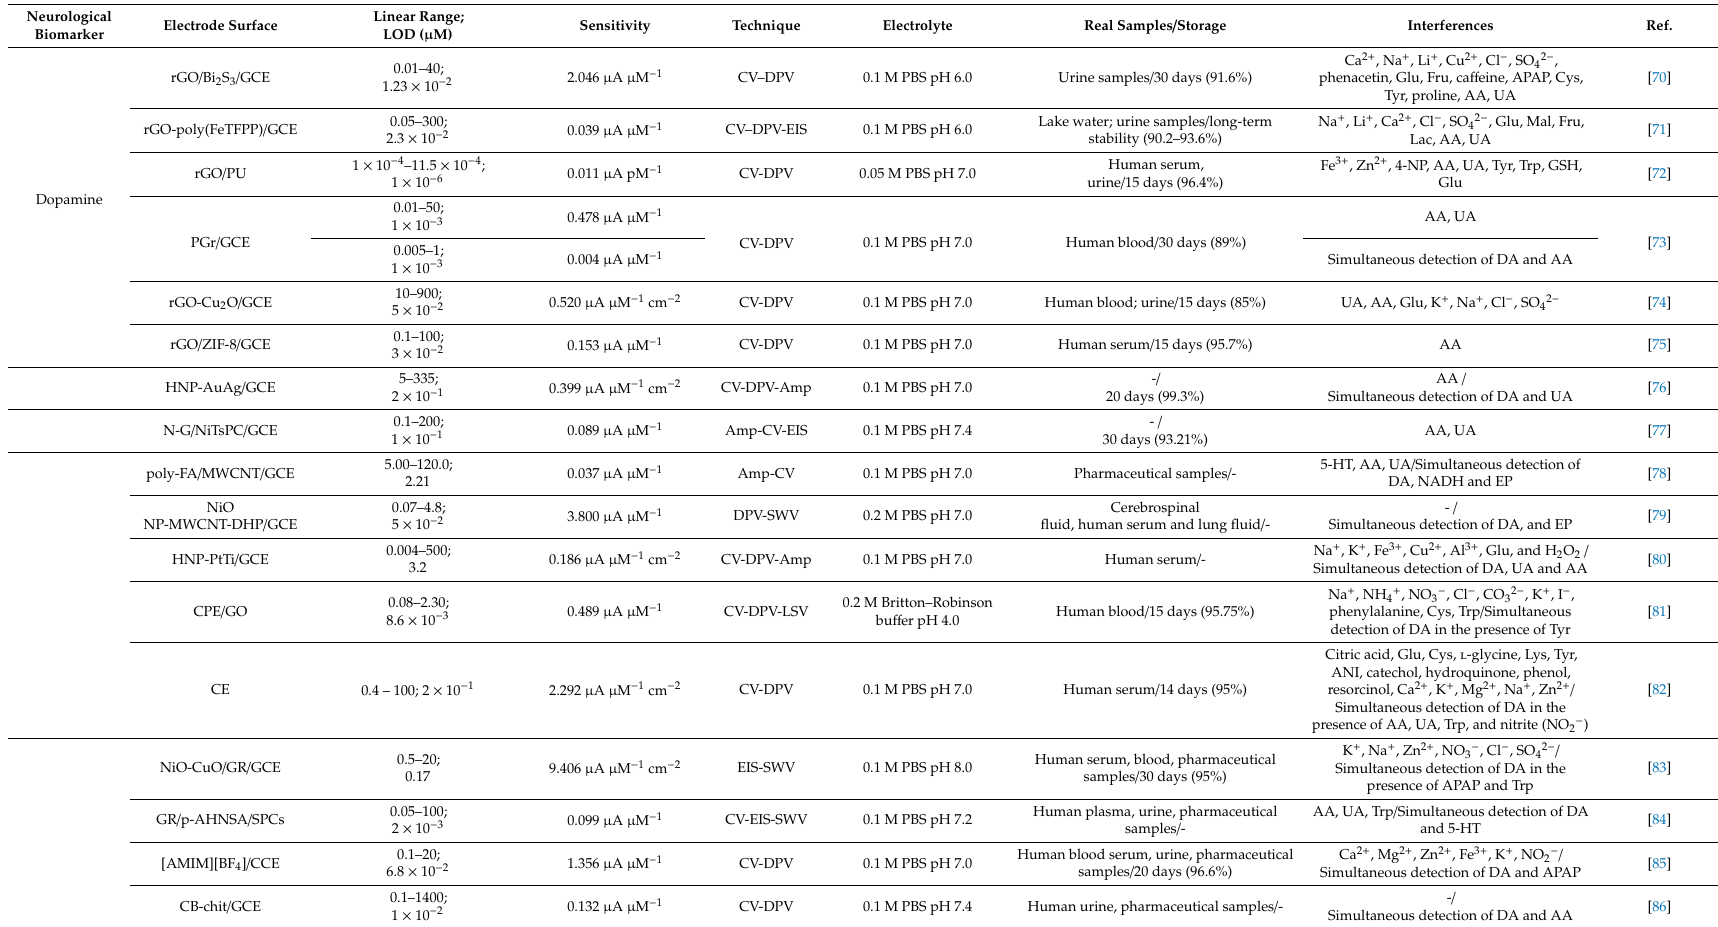
Table 2. Sensors for neurological biomarkers